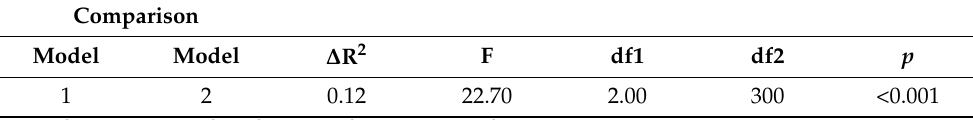
Table 7. Model Comparison for Personal